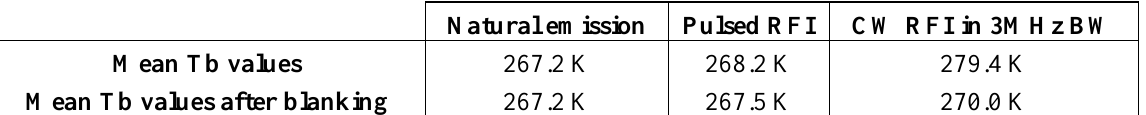
Table 3. Mean Tb values, before and after blanking, using the Euclidian distance, for each type of RFI.